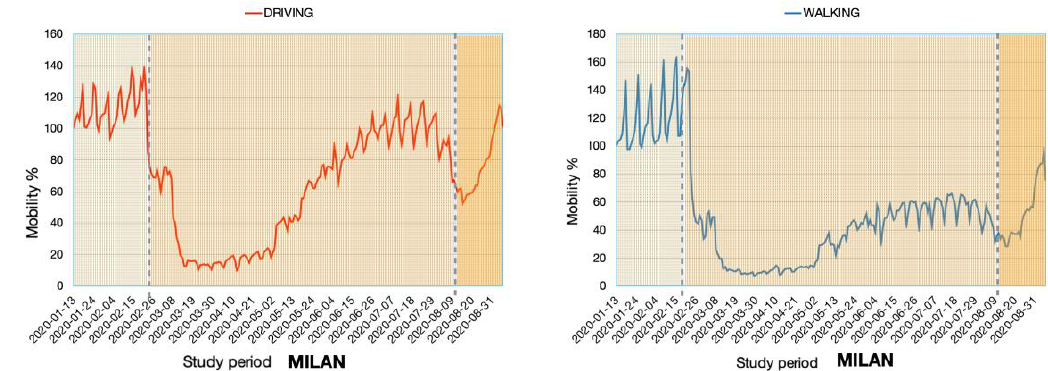
Figure 2. Mobility evolution in Milan from January until September 2020. Source: Own elaboration with data collected from Apple’s mobility trend [22].